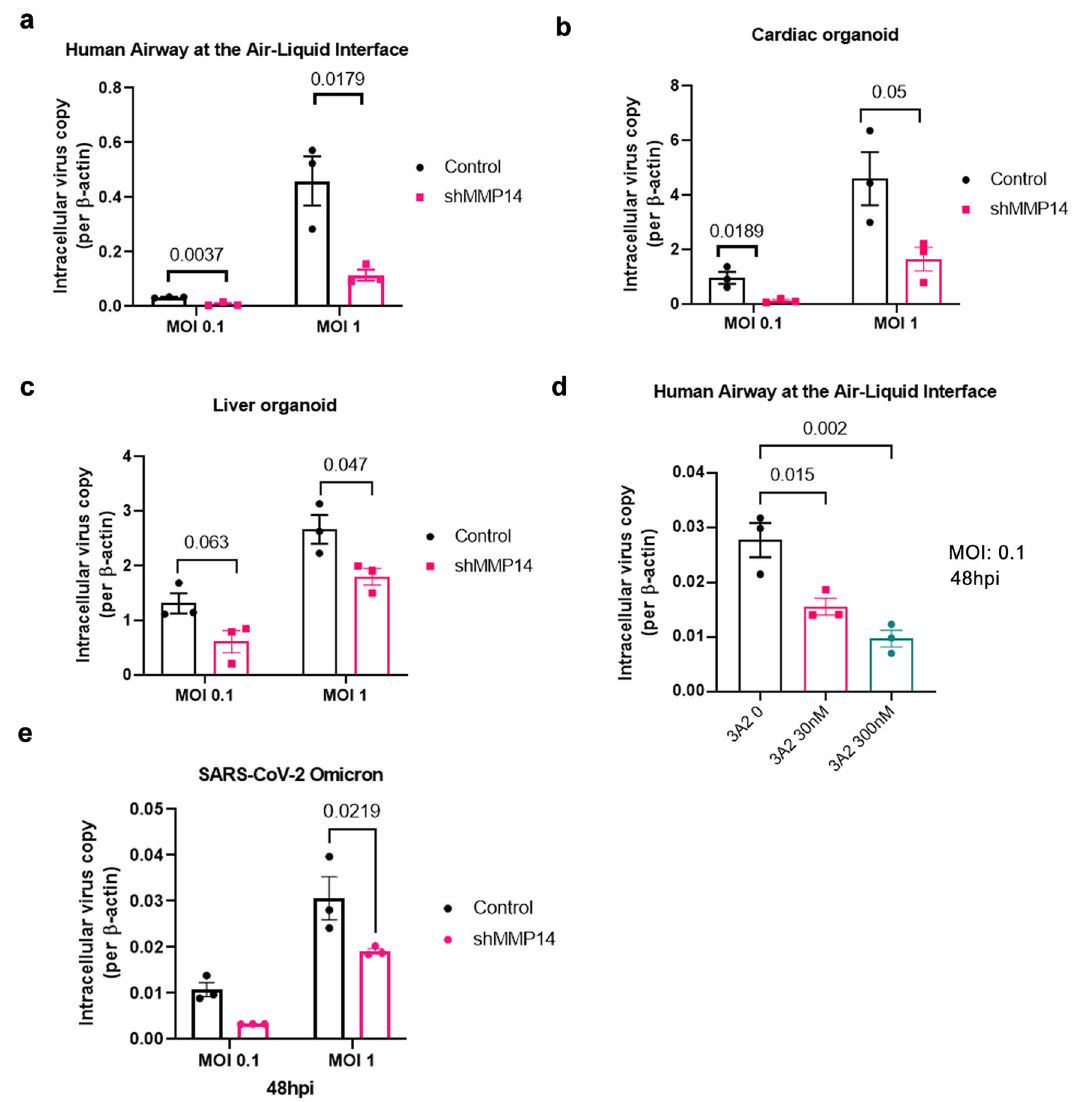
Fig. 5 | MT1-MMP inhibition suppresses SARS-CoV-2 infection in human orga- noids.a – e TheinhibitoryeffectofMT1-MMPknockdownonSARS-CoV-2infectivity inprimarycellsandorganoids.Primaryhumanbronchialepithelial3Dcultureswith an air-liquid interface (ALI) ( n =3 biologically independent experiments), human cardiac organoids formedby iPSC-derived cardiomyocytes ( n =3)and human liver organoids ( n =3) were lentivirally transduced with shRNA targeting MT1-MMP or control shRNA, following by the infection of SARS-CoV-2. d Air – liquid interface